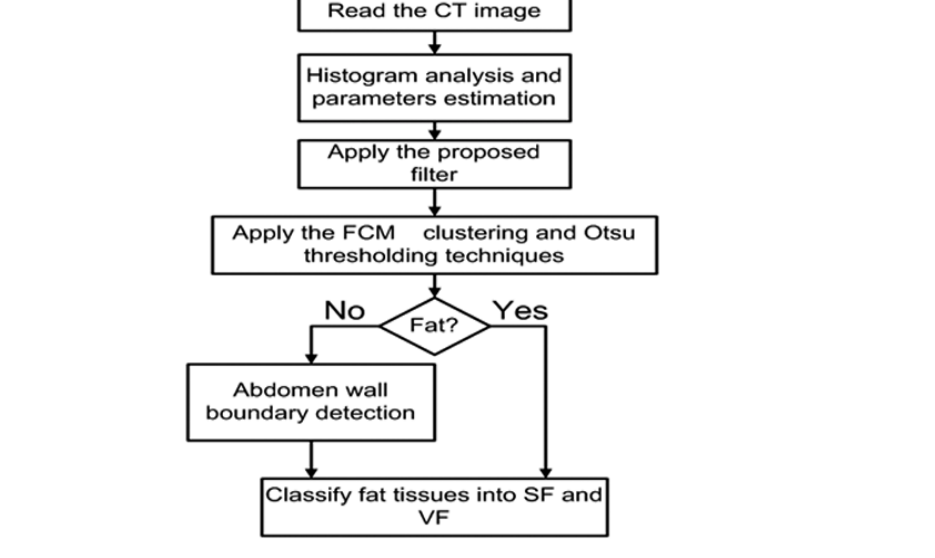
Figure 8. Structure of the abdomen fat segmentation method.